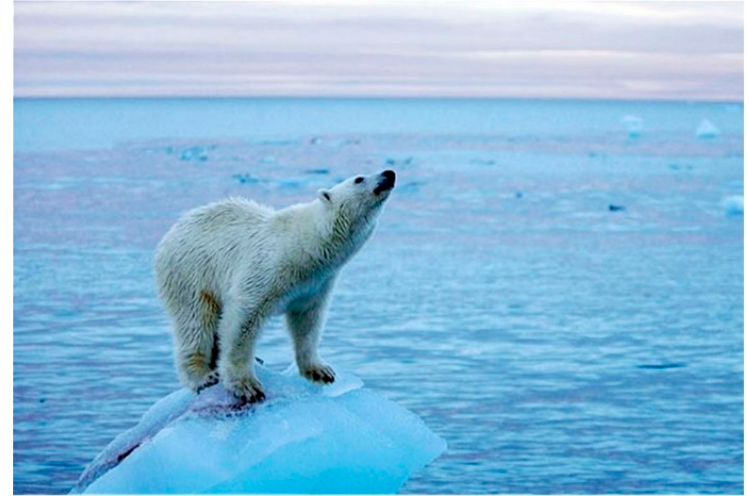
Figure A2. Stimulus Image for the Species Extinction Message.